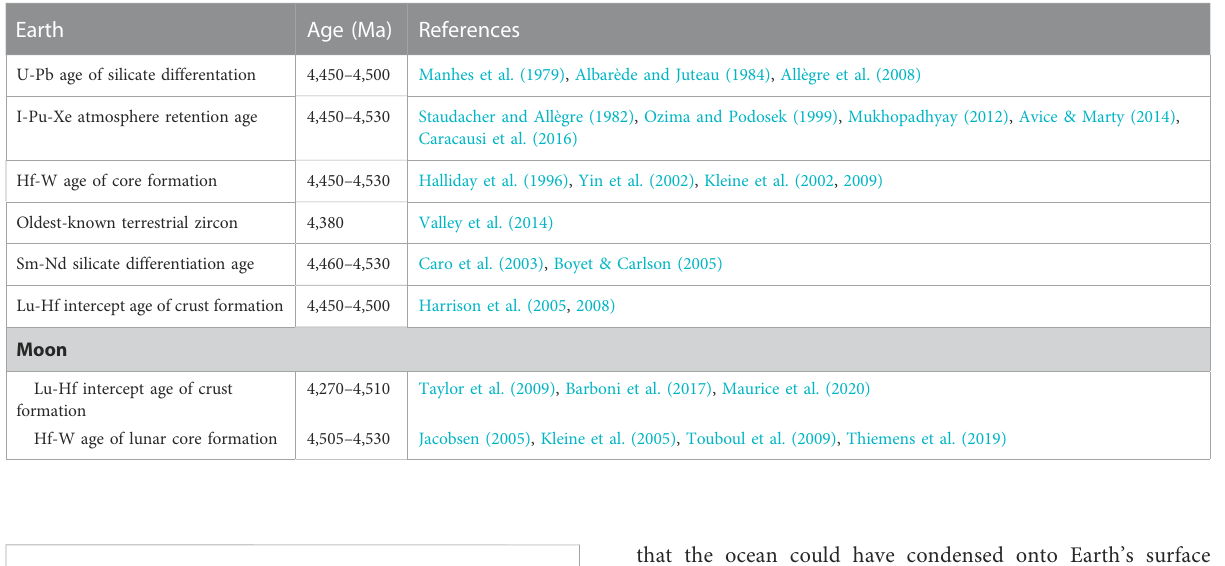
TABLE 1 Collection of published ages related to core formation, differentiation and crust formation. Ages reported here are both model/intercept ages and absolute ages, but not models of ages (after Brasser et al., 2021). Earth